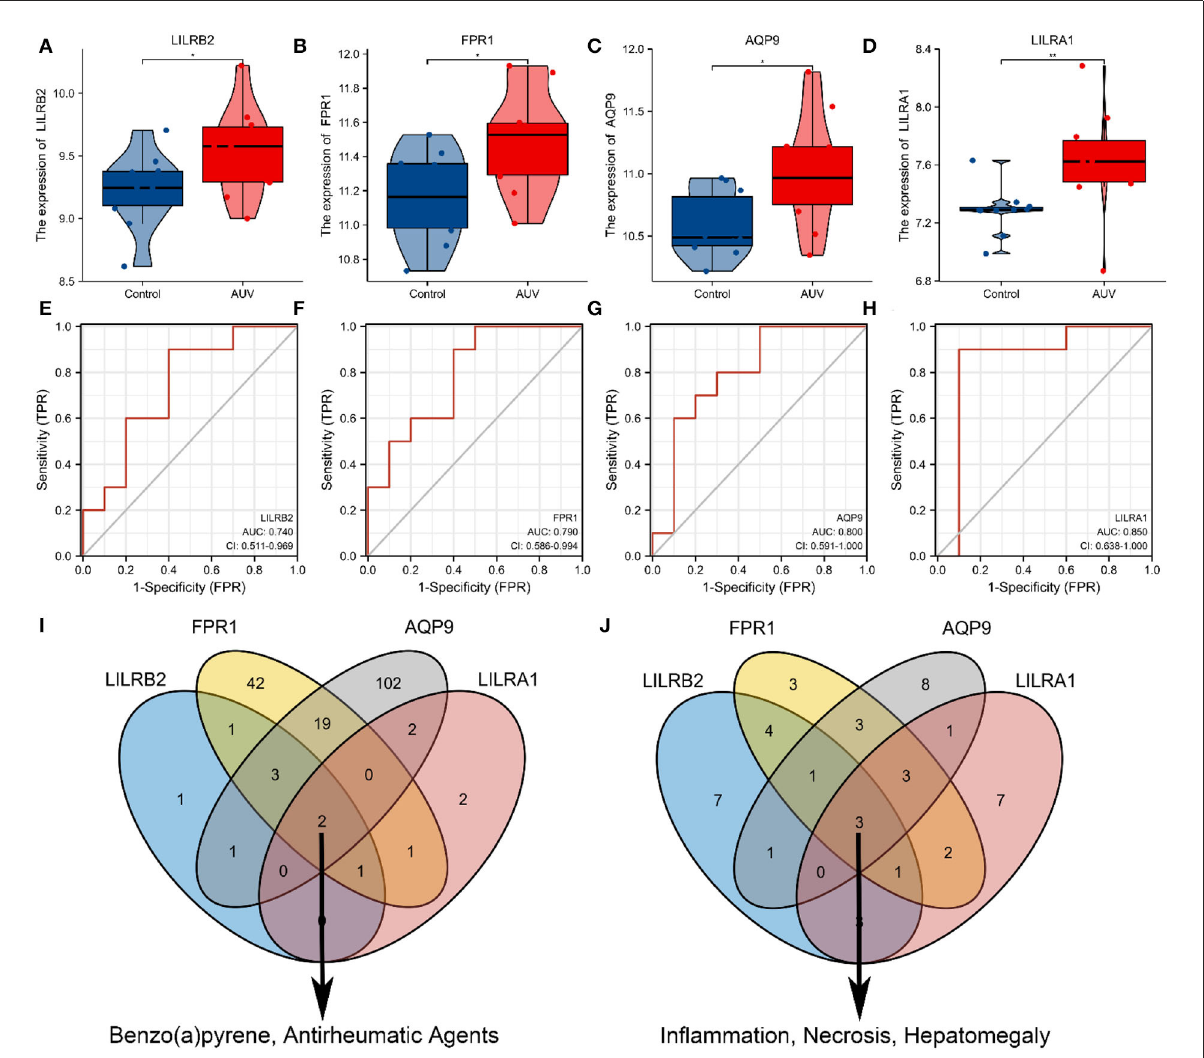
FIGURE7 Exploring the functions of four hub genes. (A) Expression of LILRB2 mRNA among Normal and AUVP. (B) Expression of FPR1 mRNA among Normal and AUVP. (C) Expression of AQP9 mRNA among Normal and AUVP. (D) Expression of LILRA1 mRNA among Normal and AUVP. (E) ROC curve validated the sensitivity and specificity of LILRB2 as a predictive biomarker for AUVP prognosis. (F) ROC curve validated the sensitivity and specificity of FPR1 as a predictive biomarker for AUVP prognosis. (G) ROC curve validated the sensitivity and specificity of AQP9 as a predictive biomarker for AUVP prognosis. (H) ROC curve validated the sensitivity and specificity of LILRA1 as a predictive biomarker for AUVP prognosis. (I) The Venn plot of the four hub genes related to chemicals in the CTD. (J) The Venn plot of the four hub genes related to diseases in the CTD (* p < 0.05; ** p < 0.01; ns, the difference is not statistically significant; CTD, Comparative Toxicogenomics